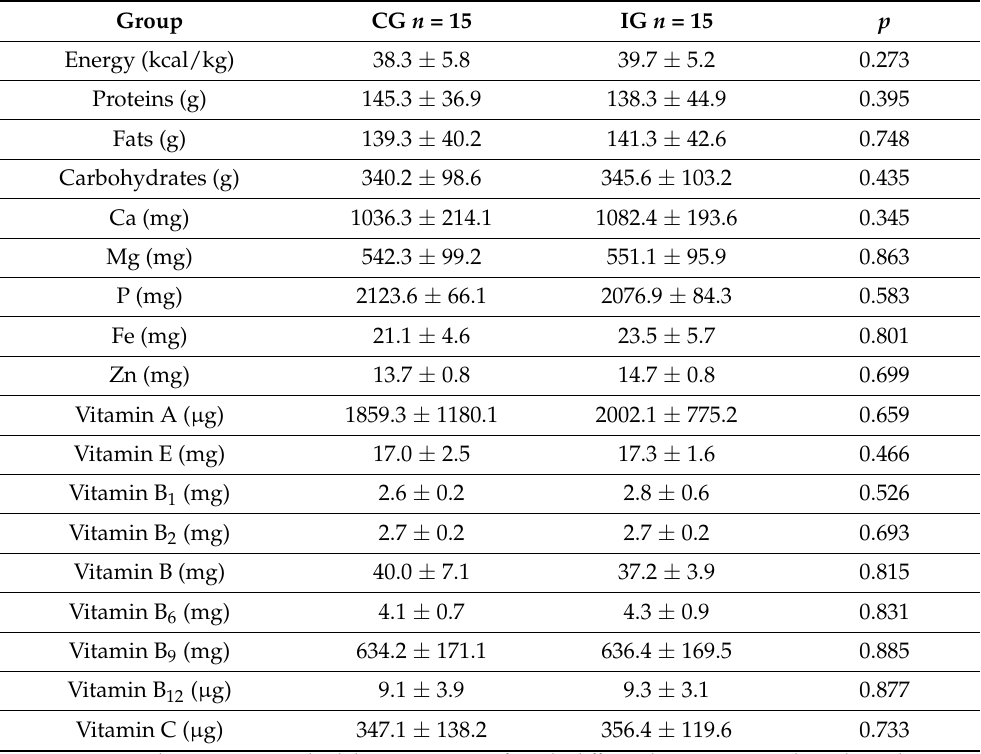
Table 2. Energy and micronutrients intake in control group (CG) and intervention group (IG) during 6 weeks of